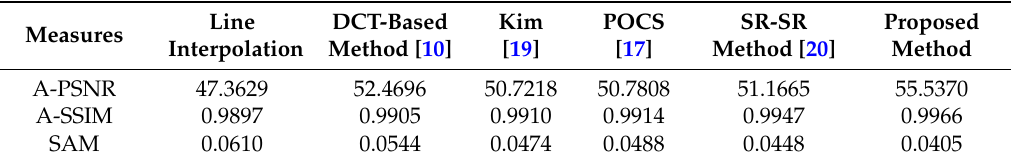
Figure 11. False color image of experimental results for the Jinyin Tan dataset 2 (color composite of R: 48, G: 30, B: 11). ( a ) original HR image; ( b ) linear interpolation results; ( c ) DCT-based method [10] results; ( d ) Kim [19] results; ( e ) POCS [17] results; ( f ) SRSR [20] results; ( g ) proposed APOCS-BM method results. Table 4. Comparison results of A-PSNR, A-SSIM and SAM in the Jinyin Tan dataset